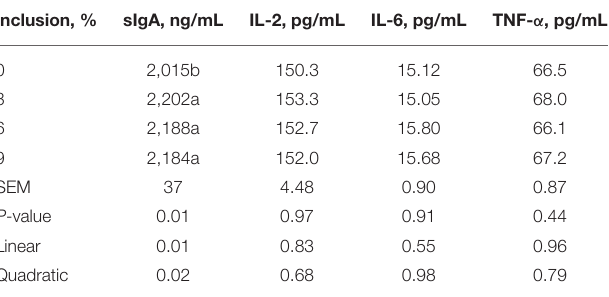
TABLE 5 | Effect of dietary low-inclusion levels of full-fatted black soldier fly larvae meal on ileum mucosal immunity of layer chickens at 42 days of age (each value represents the mean of six replicates).